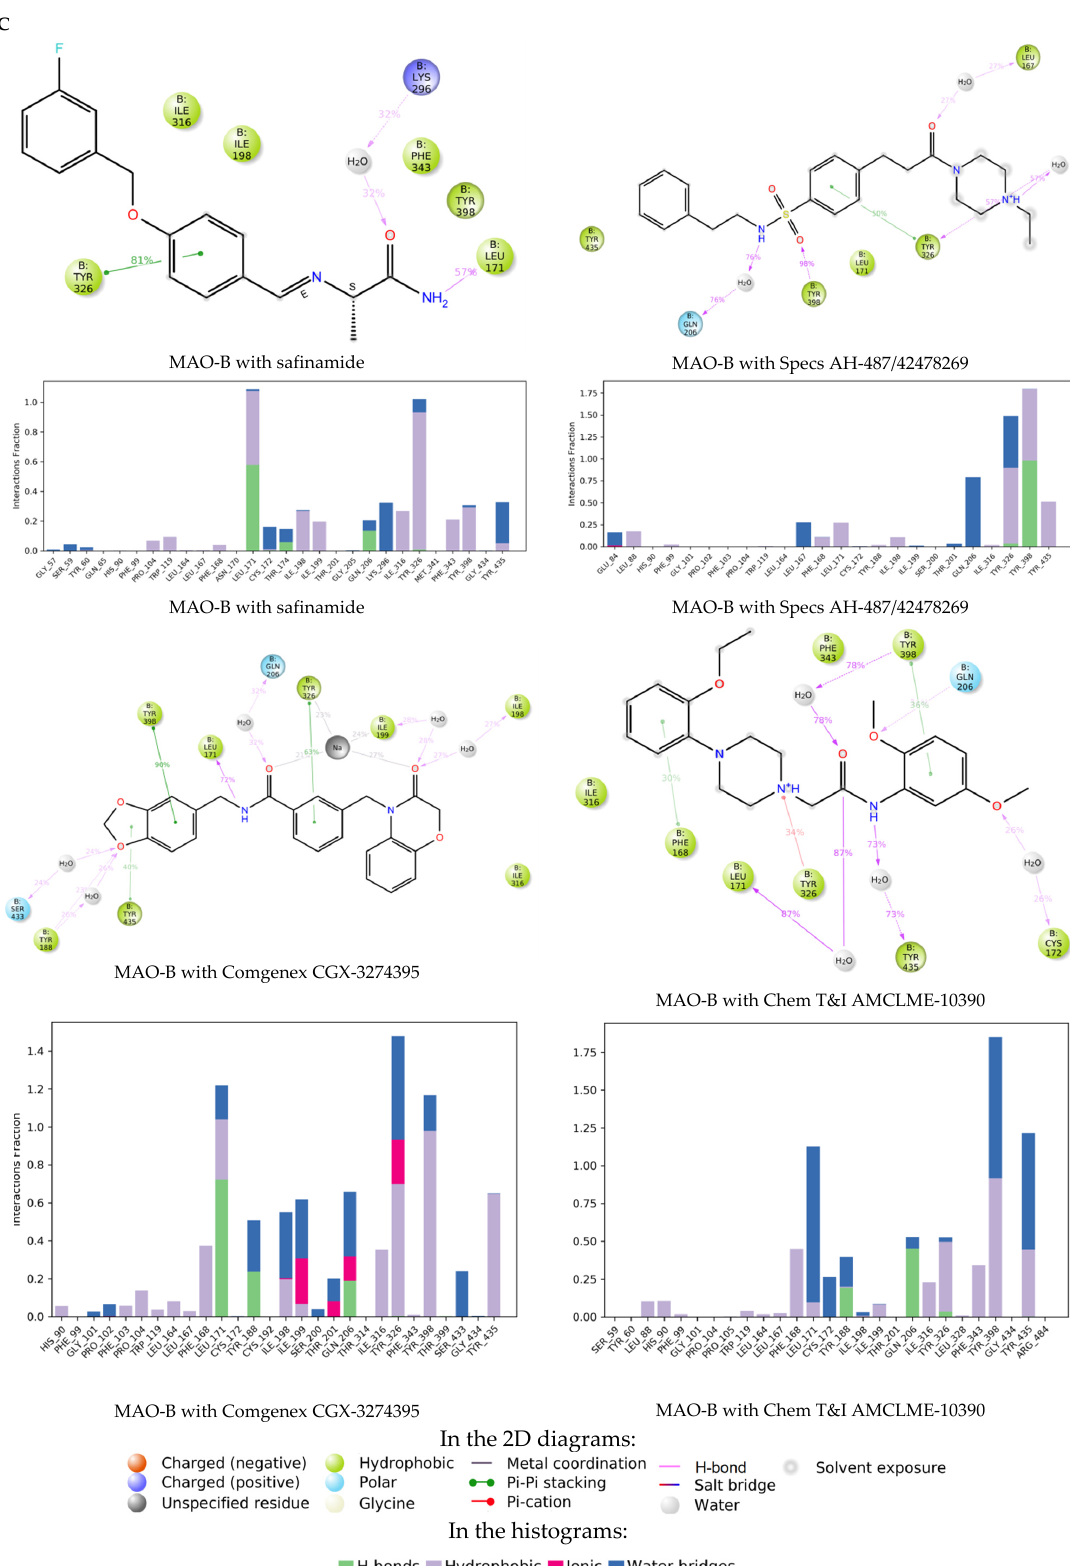
Figure 7. Protein-ligand interactions for the enzyme complexes with reference ligand/hit